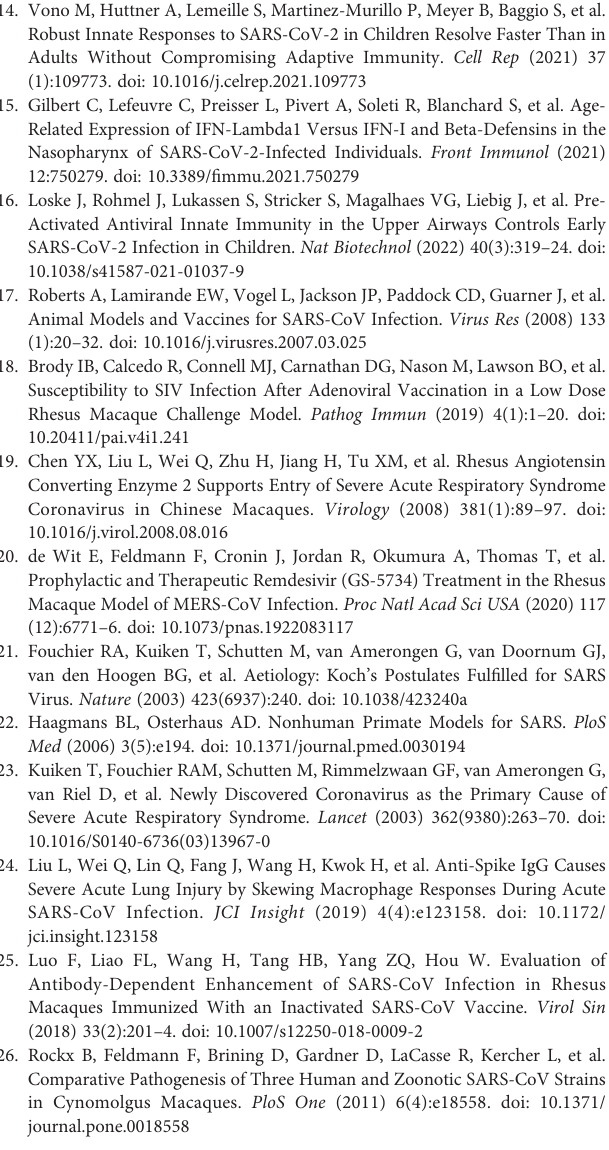
Supplementary Figure 4 | Hematological parameters of infected adults. Hemoglobin concentration and absolute numbers of white blood cells, neutrophils, lymphocytes, red blood cells, monocytes, eosinophils, basophils in adults from three studies (pink, green and blue lines). The horizontal dashed lines stand for median with standard deviations according to reference values (68, 69). The vertical red dashed line indicates viral inoculation at DPI 0. Supplementary Figure 5 | SARS-CoV-2 infection in adults. Viral RNA load measured by RT-qPCR in the fl uidic compartments. The limit of detection was estimated at 2.37 log10 copies per ml and the limit of quanti fi cation was estimated at3.37log10copiesperml(dottedhorizontalline).Macaqueswereincludedinthree studies with speci fi c SARS-CoV-2 inoculated doses: MM1-4 received 1x10 5 CFU (pink), MM5 received 1x10 6 CFU (green) and MM6-7 received 1x10 7 CFU (blue).